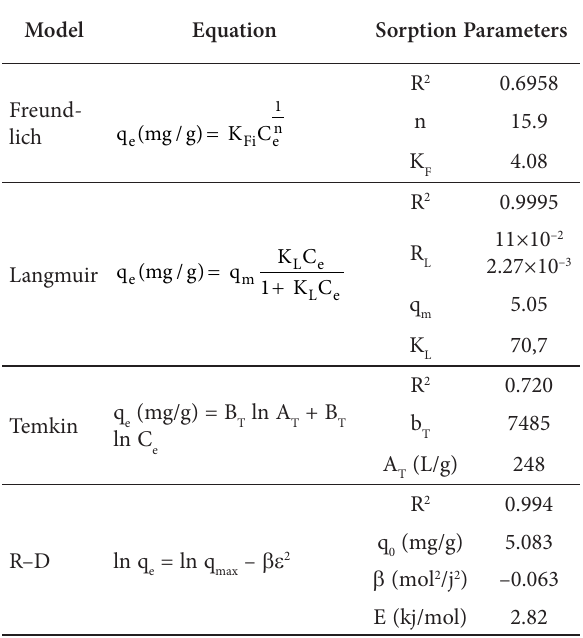
Table 1. Correlation coefficient and sorption parameters for various models Model Equation